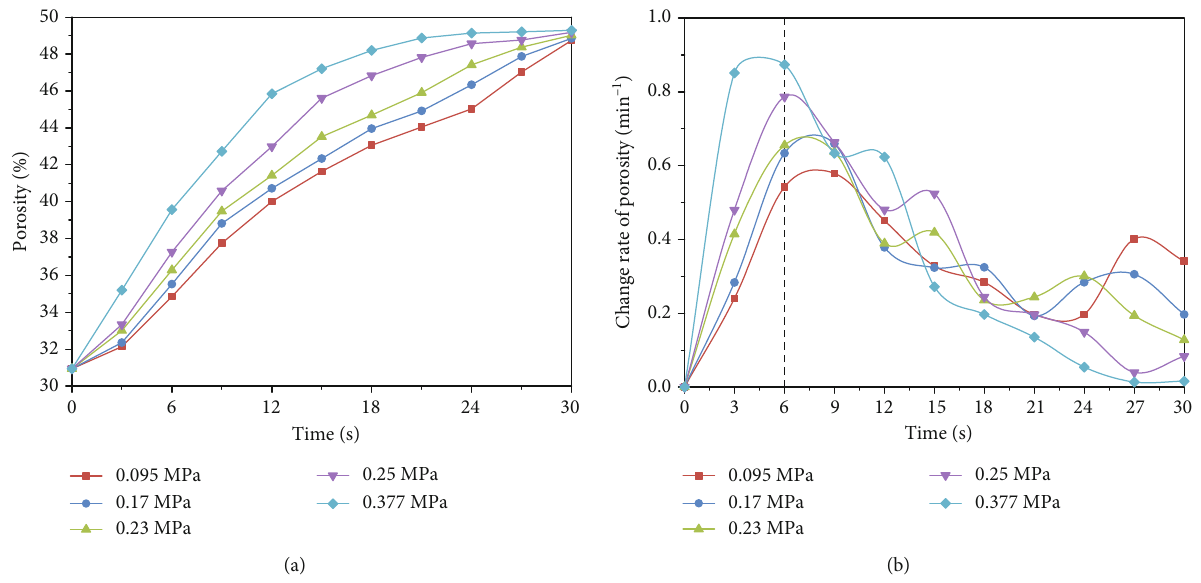
Figure 12: The evolution of (a) porosity and (b) change rate of porosity with time for various water pressure di ff erences.